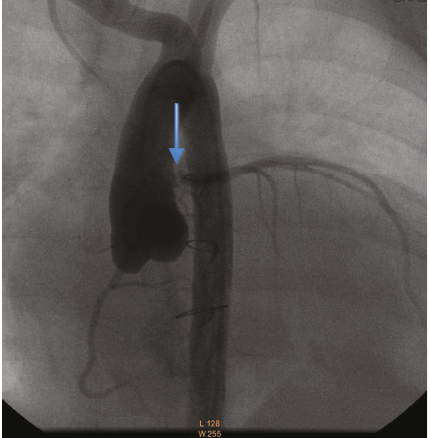
Figure 1: Coronary angiography demonstrating ostial LMCA stenosis.